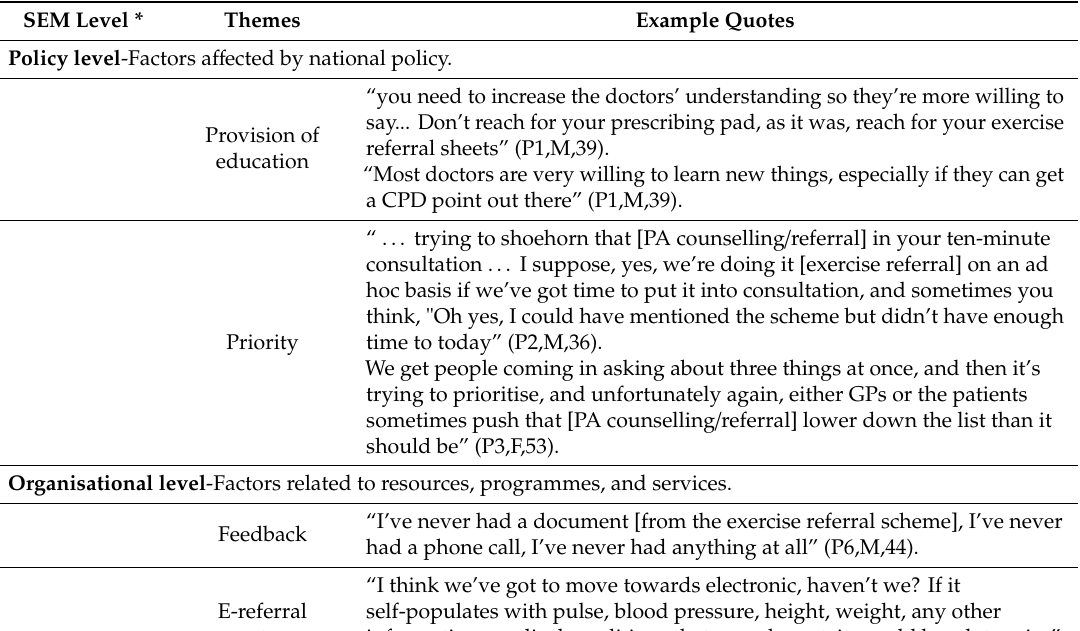
Table 3. Summary of factors influencing GP PA promotion embedded within the SEM: Qualitative interview